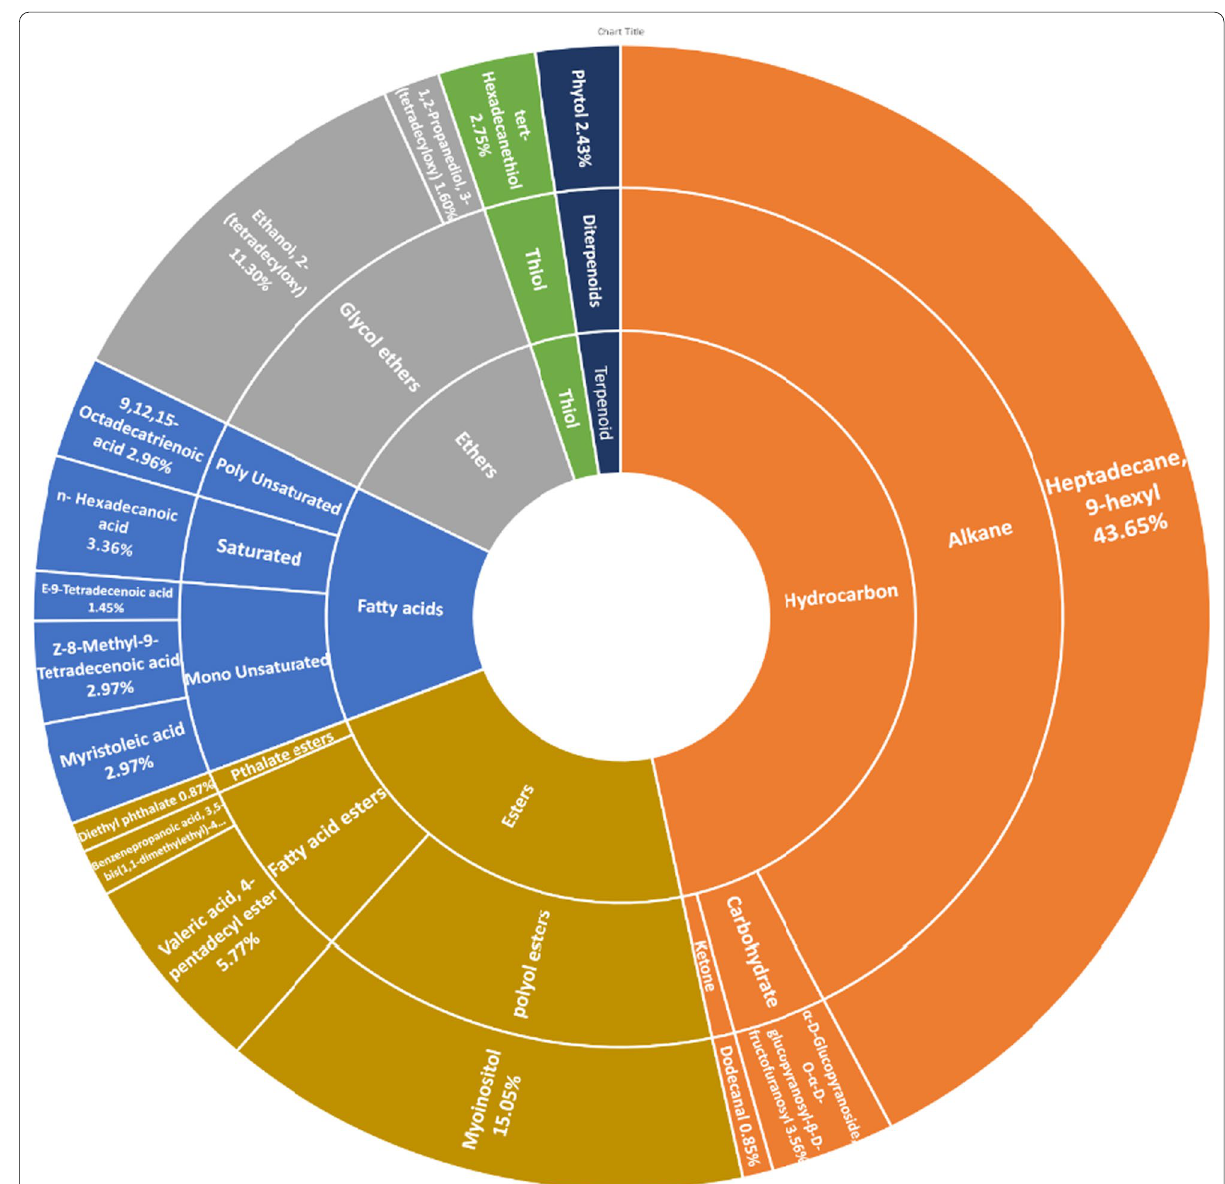
Fig. 3 Sunburst chart representing variation in phytoconstituents in Solanum khasianum leaf